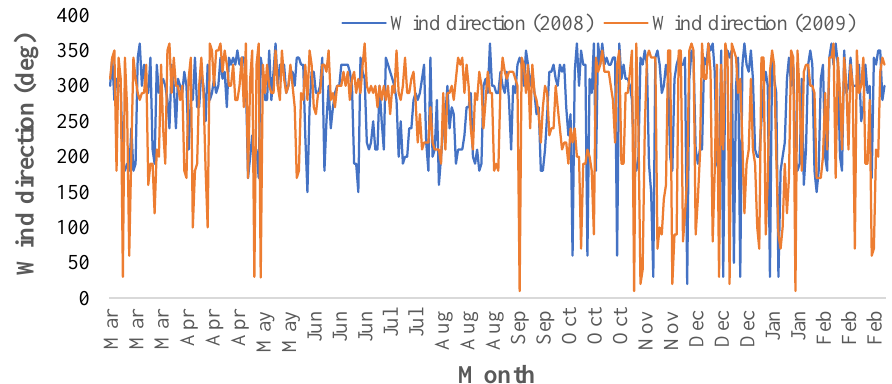
Figure 4. Wind speed time series in 2008 and 2009.